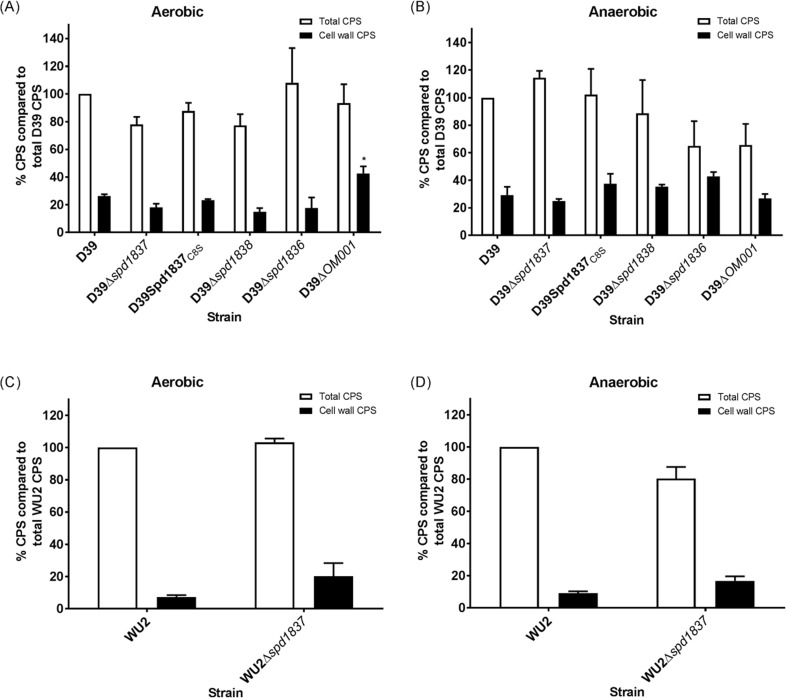
CPS production by D39 and WU2 strains.CPS was prepared from equal numbers of bacterial cells of D39, D39Δspd1837, D39Spd1837C8S, D39Δspd1838, D39Δspd1836, and D39ΔOM001 grown either aerobically (A) or anaerobically (B) and WU2 and WU2Δspd1837 grown either aerobically (C) or grown anaerobically (D). The CPS level was determined by uronic acid assay as described in Materials and Methods. The white bars represent the total CPS produced by various mutants as a percentage of total D39 CPS ((A) and (B)) or total WU2 CPS ((C) and (D)). The black bars represent the cell wall-associated CPS produced by mutants as a percentage of total D39 CPS ((A) and (B)) or total WU2 CPS ((B) and (C)). Bars represent means from three independent replicates while the error bars represent the standard error.